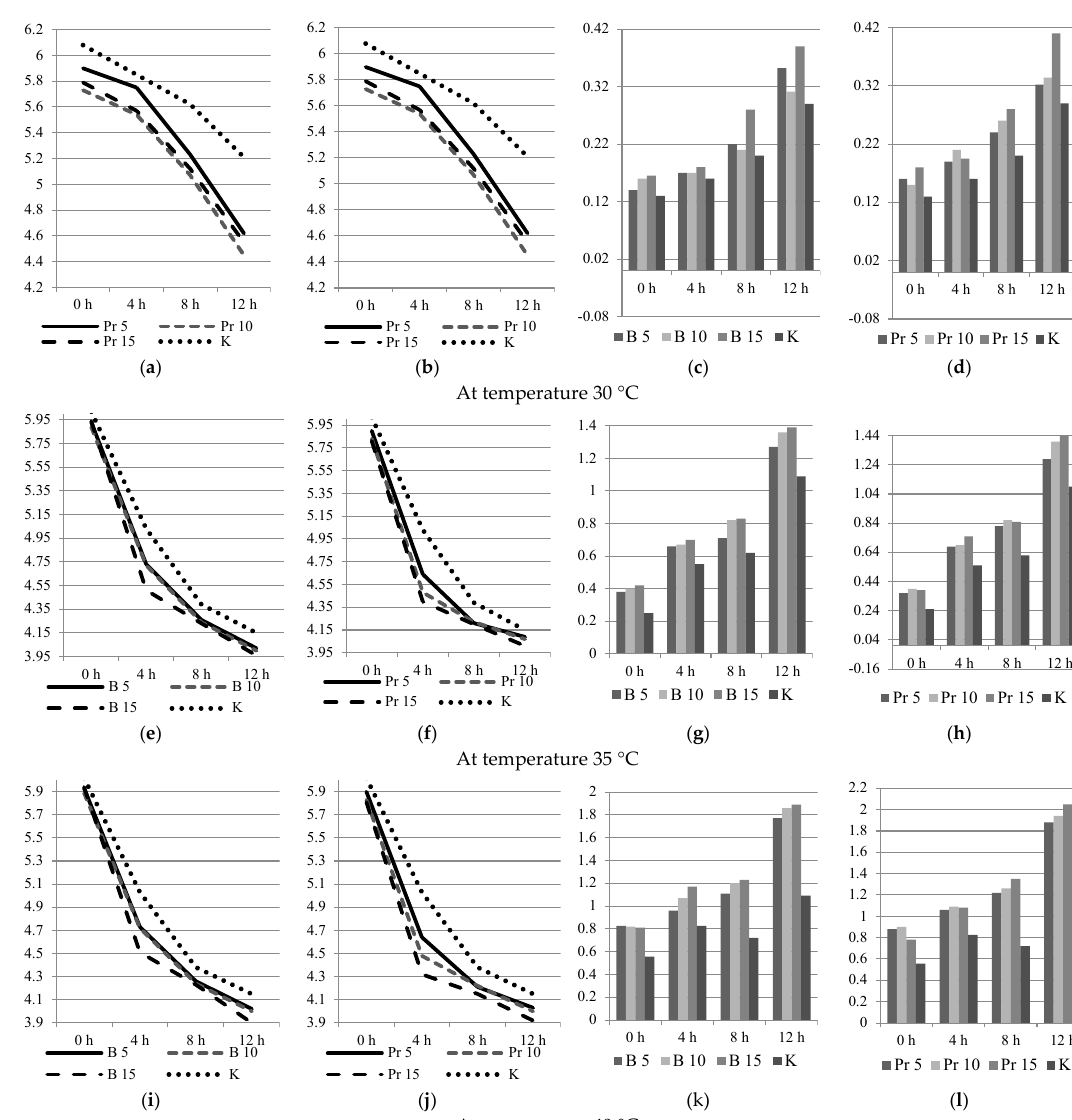
Figure 3. Dynamics of the acidity of broiler chicken gizzards during the hydrolysis period—at temperature 30 °C: ( a ) рН level, when treated with BLC; ( b ) рН level, when treated with Propionix LCSC; ( c ) titrated acidity, when treated with BLC; ( d ) titrated acidity, when treated with Propionix LCSC; at temperature 35 °C: ( e ) рН level, when treated with BLC; ( f ) рН level, when treated with Propionix LCSC; ( g ) titrated acidity, when treated with BLC; ( h ) titrated acidity, when treated with Propionix LCSC; at temperature 40 °C: ( i ) рН level, when treated with BLC; ( j ) рН level, when treated with Propionix LCSC; ( k ) titrated acidity, when treated with BLC; ( l ) titrated acidity, when treated with Propionix LCSC.